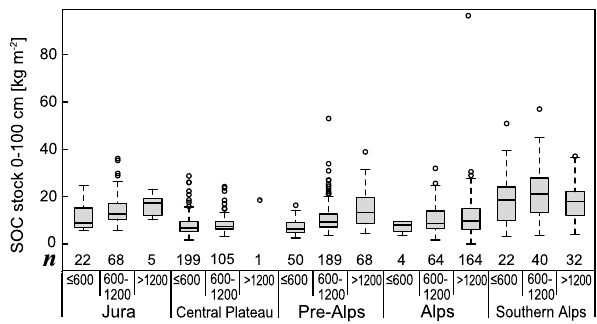
Figure 3. Boxplots of calculated soil organic carbon (SOC) stocks in 0–100cm depth by ecoregion and altitudinal class ( n : number of